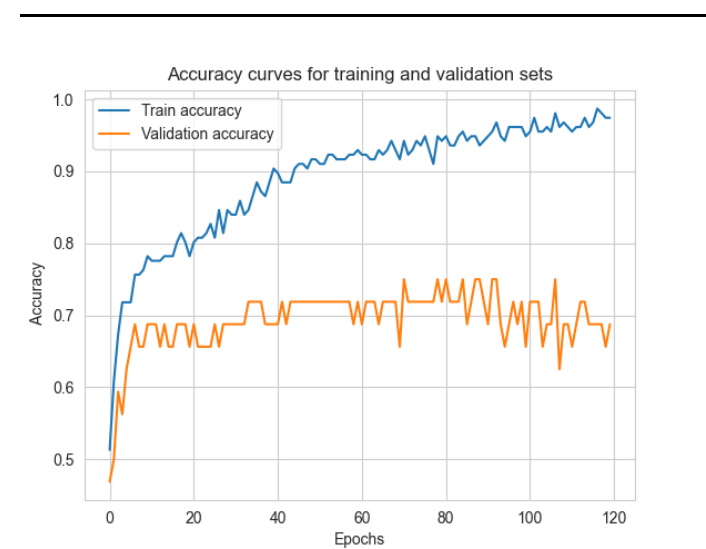
Figure 9. Accuracy curves of training set and validation set during